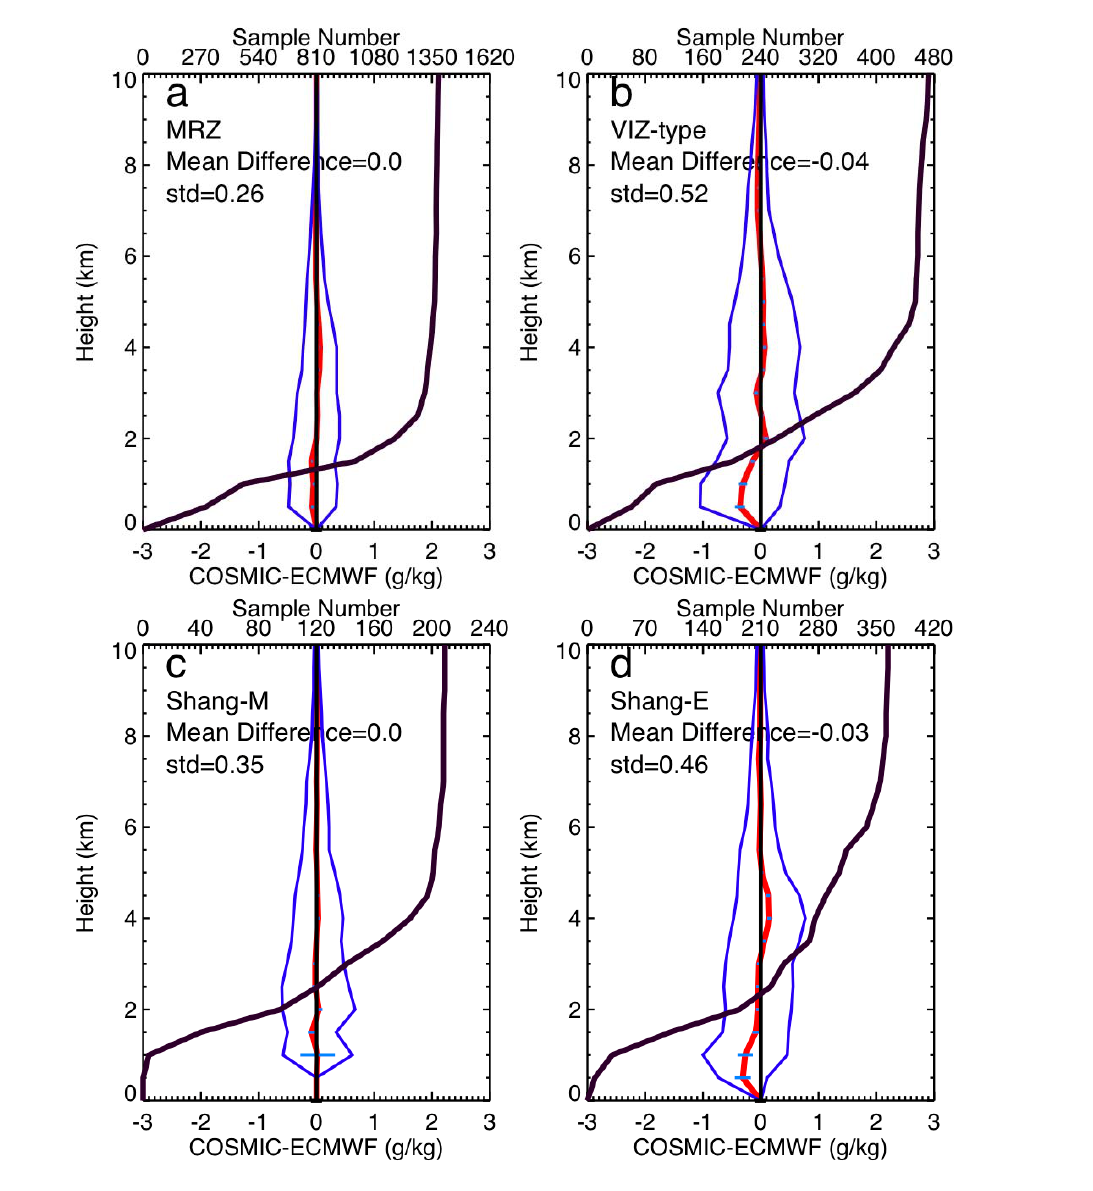
Figure 2 . Comparison statistics (mean: red; standard error of the mean: horizontal light blue lines superimposed on the mean; mean  standard deviation: blue; sample number of compared soundings: solid black line) of specific humidity (g/kg) of COSMIC-ECMWF pairs (a) near MRZ radiosondes, (b) near VIZ-type radiosondes, (c) near Shang-M radiosondes, and (d) near Shang-E